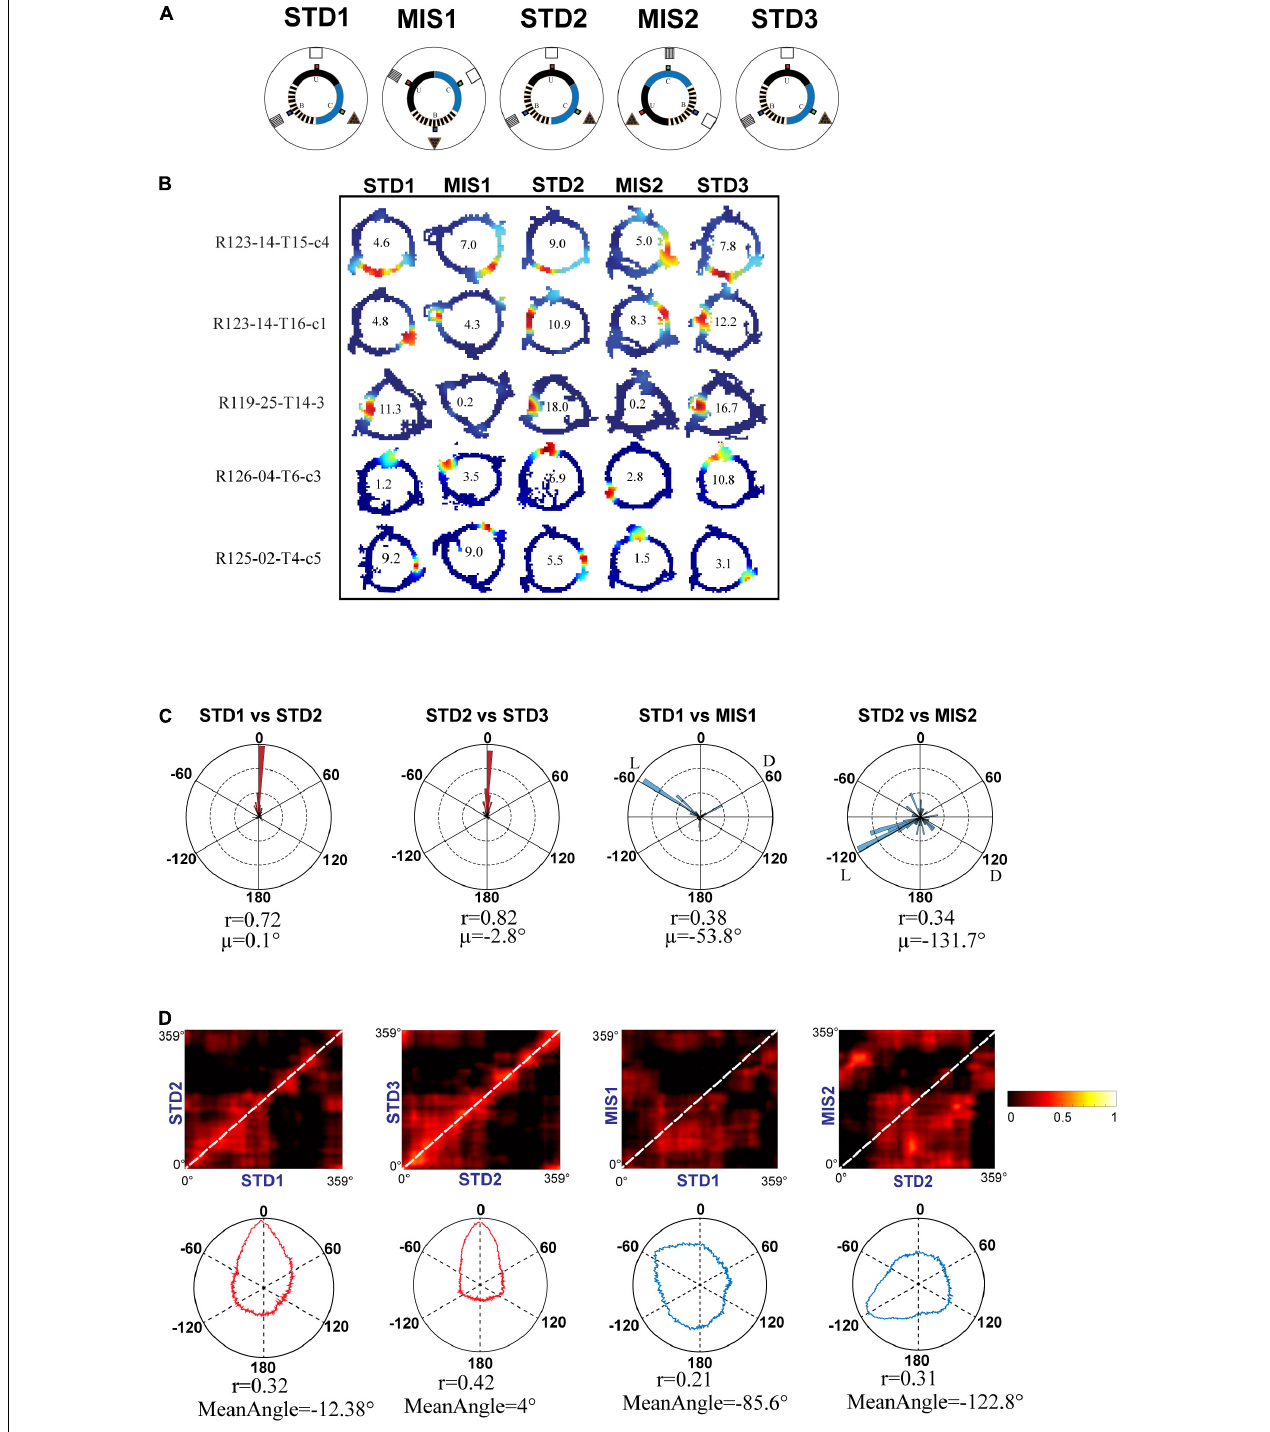
FIGURE 10 | Schematic representation of double rotation experiments with different reward flavors and surface textures as local cues (RwdFlav + Tex). (A) Schematic representation of the reward flavor + texture–a distal cue double-rotation paradigm. The blue dot indicates the spoke where banana flavored-pellets (B) were provided, the red dot indicates the spoke where sucrose pellets (U) were provided, and the green dot indicates the spoke where chocolate-flavored pellets (C) were provided. (B) Representative place fields from different experimental days from five sessions. (C) Circular histogram of place field rotation in standard and mismatch comparisons. L and D indicate the rotation of local and distal cues. (D) Population correlation matrices and the corresponding polar plot of standard and mismatch comparisons.